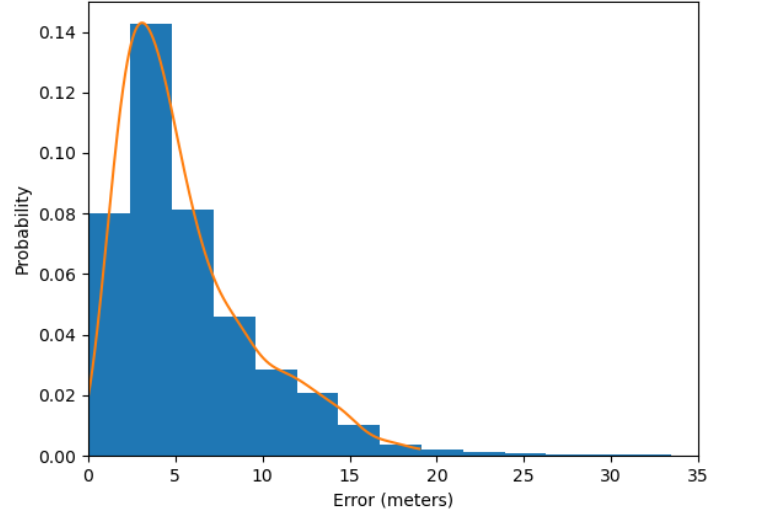
Figure 11. A probability distribution of GPS errors between the predicted geo-localized sign coor- dinates and the actual coordinates from the annotations. The x -axis indicates the amount of GPS error in meters between a predicted and an actual sign, and the y -axis indicates the probability of a random sign having the error indicated on the x